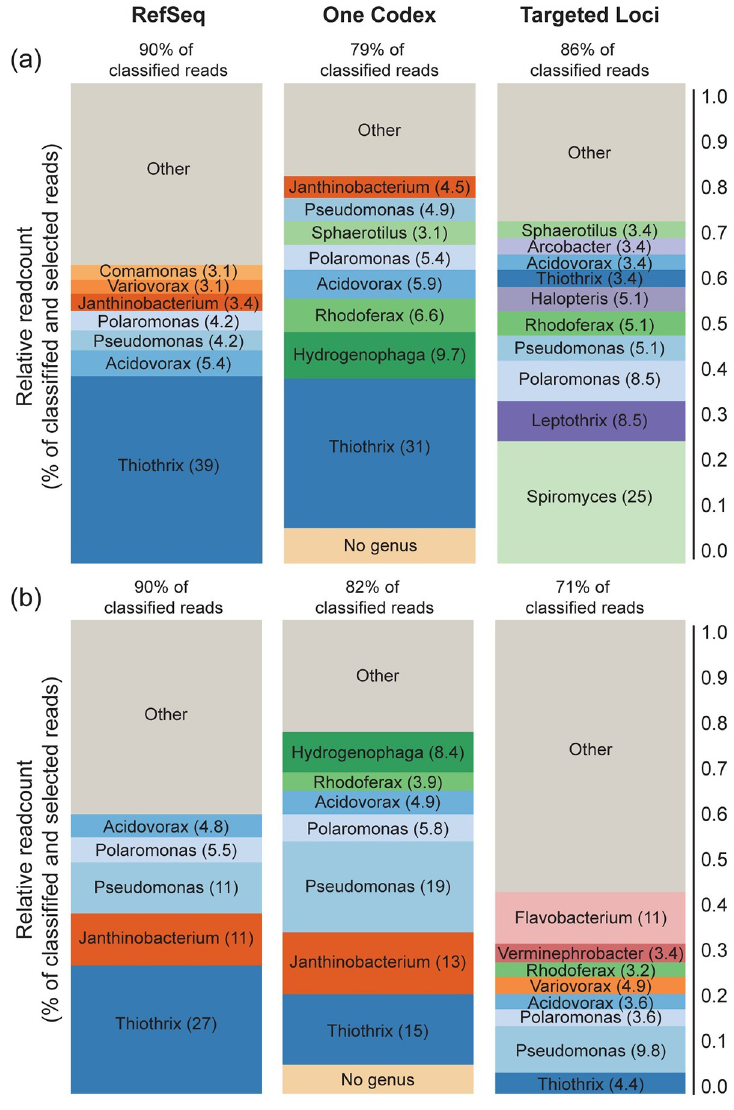
Fig 8. Normalized genus-level taxonomic alignment of WMS sequence data for samples collected from DS1 on (a) February 24, 2010, and (b) March 18, 2010. Alignments were limited to those having at least 3% representation with sequences in the RefSeq Complete Genomes, One Codex, and targeted loci databases. Values above bars indicate the percent of reads from the sample that aligned with genus or species level sequences in the indicated database. Values on the bars indicate the relative percentage of aligned sequences that matched to indicated